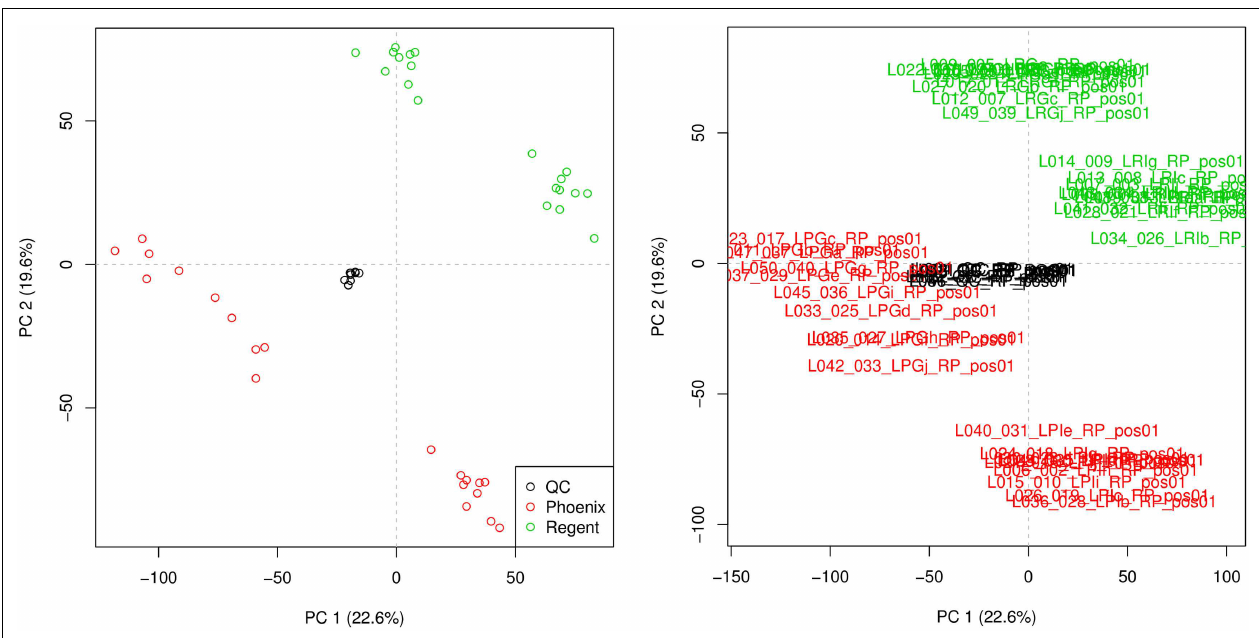
FIGURE 3 | Principal component analysis scoreplot produced by metaDB on the example dataset . Different colors are used to identify the two different sample classes and the QCs.The different samples can be identified also by their sample names.This feature can be useful for the fast identification of critical samples.